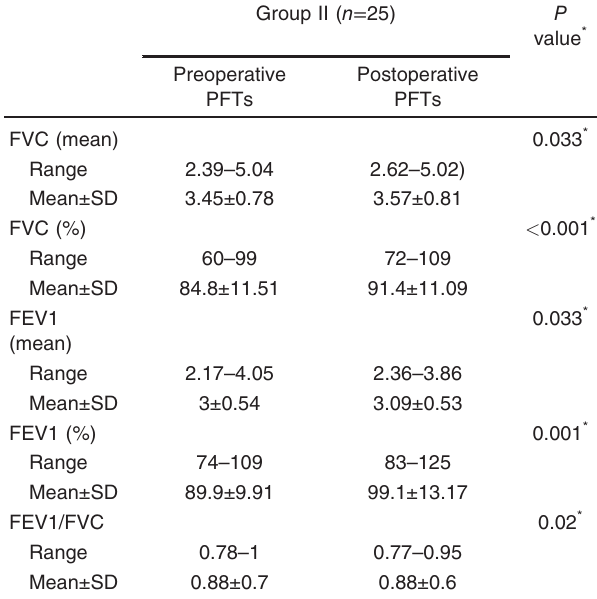
Group I pulmonary function tests values versus group II preoperative pulmonary function tests values